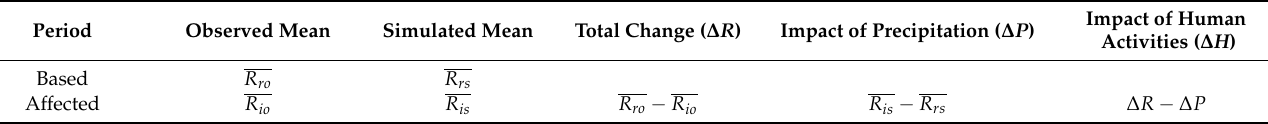
Table 2. Analytical method of the contributions of the climate change and human activities to change in the runoff.